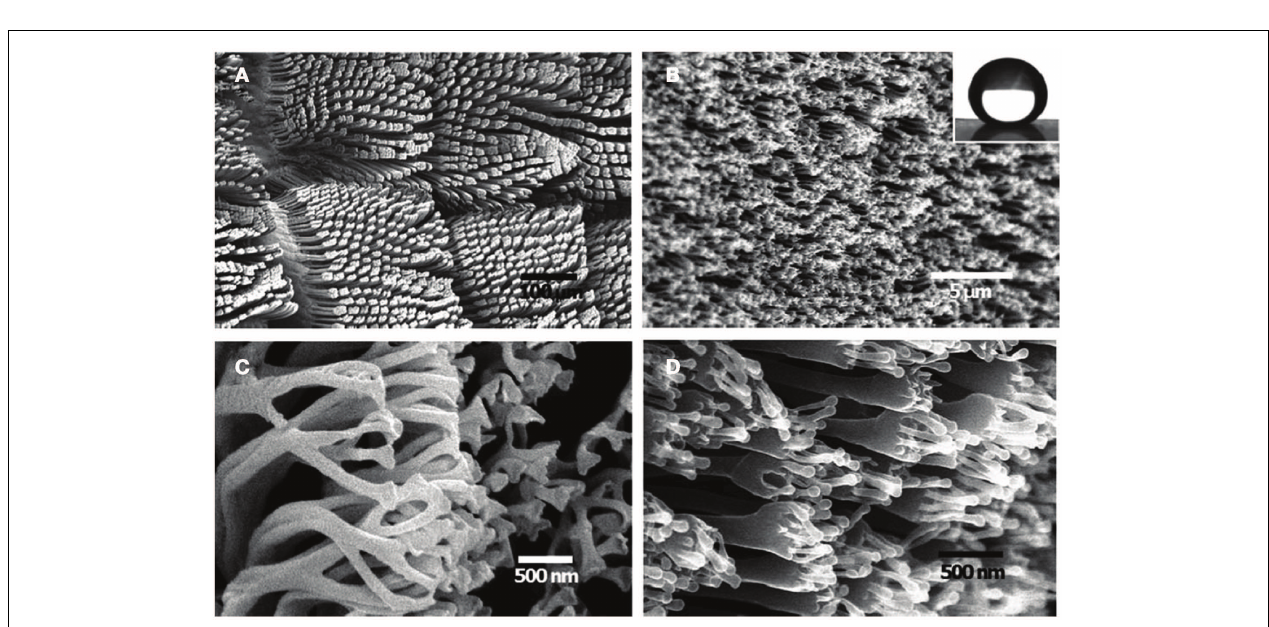
FIGURE 1 | Structural hierarchy of the gecko adhesive system. (A,B) Gecko toe pads. (C) Gecko setae. (D) A single seta of the tokay gecko. (E) Gecko spatulae. From Autumn et al. (2006a).